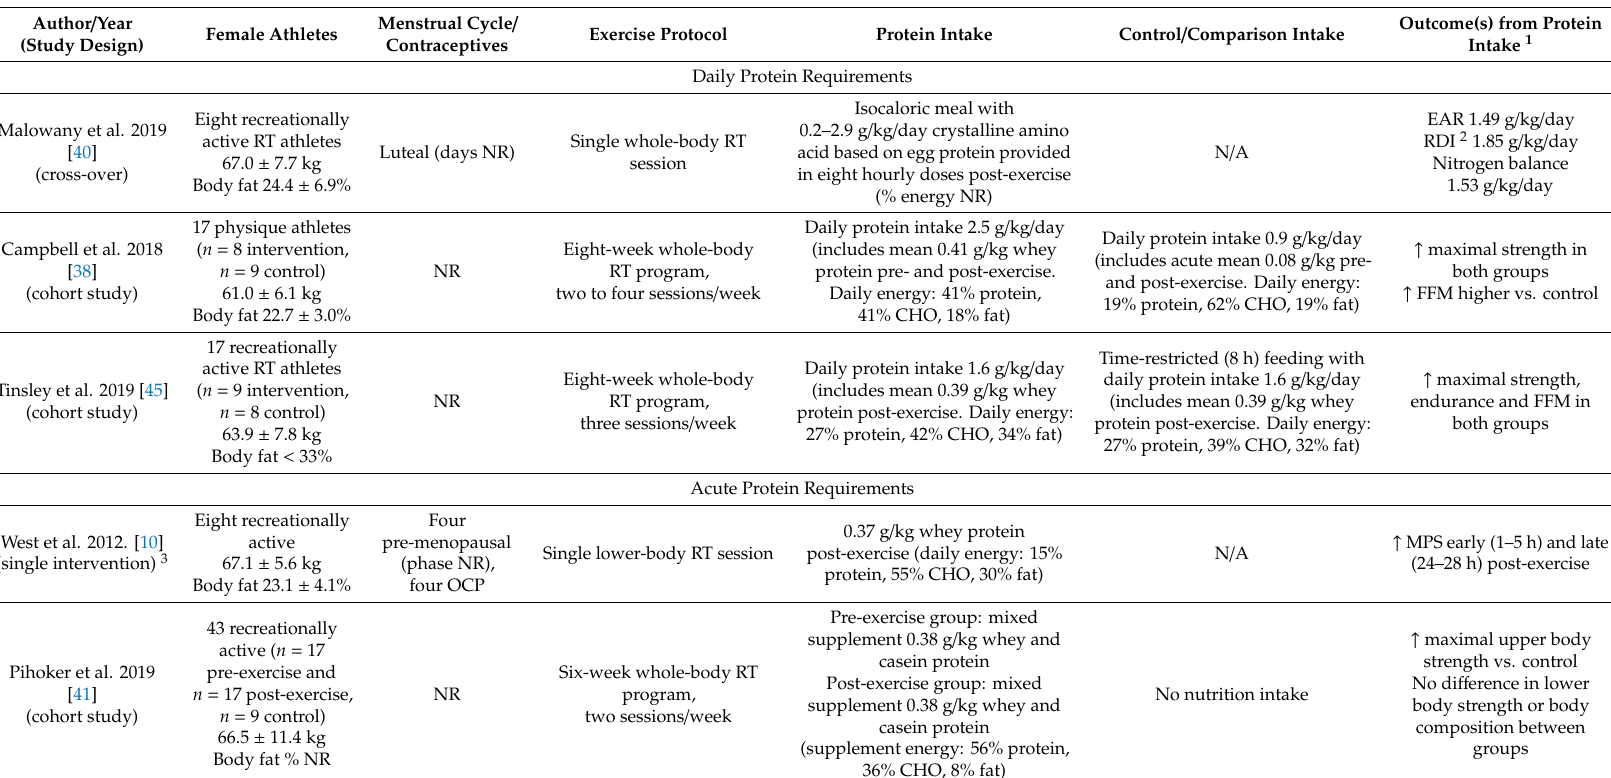
Table 3. Protein requirements of female athletes completing resistance